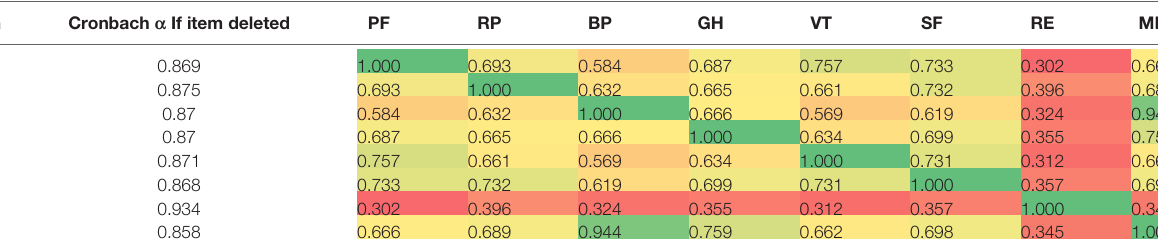
TABLE 4 | PHQ-9 Cronbach a and correlation coef fi cient of different items. Entry